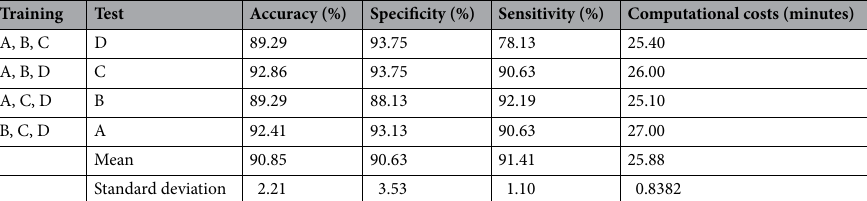
Table 2. Results from k-fold